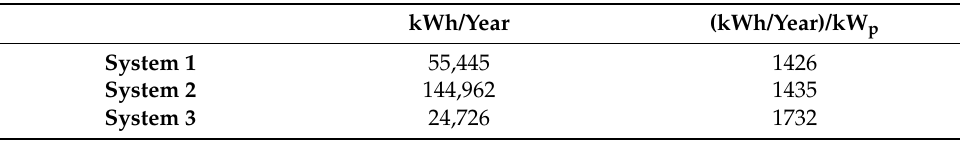
Table 3. Yearly energy production of each system